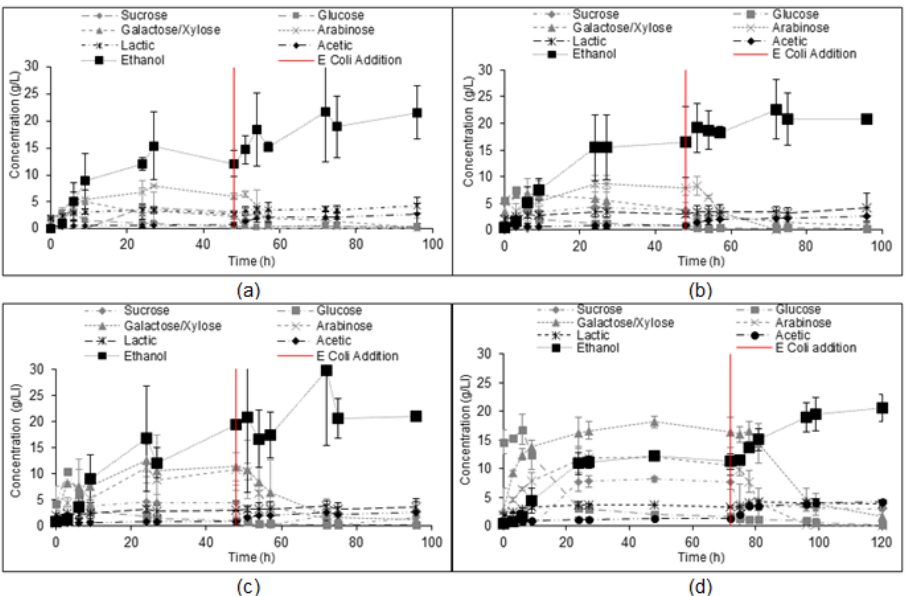
Figure 2. Effect of PCX (pectinase, cellulase, and xylanase) concentrations ( a ) 5%, ( b ) 10%, ( c ) 15%, and ( d ) 20% of soy solids on the carbohydrate profile and ethanol production during S. cerevisiae fermentation of IF. Error bars show standard deviations. Vertical red line indicates when E. coli KO11was added.